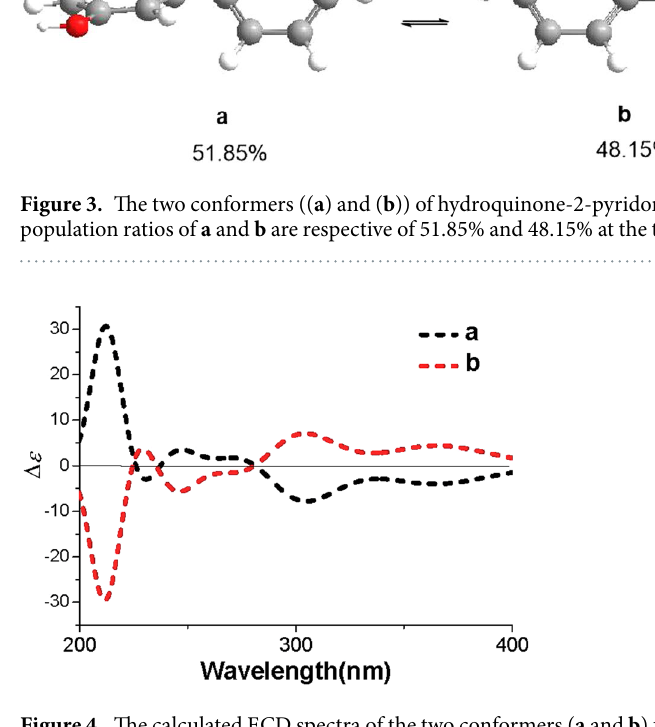
Figure 4. The calculated ECD spectra of the two conformers ( a and b ) for